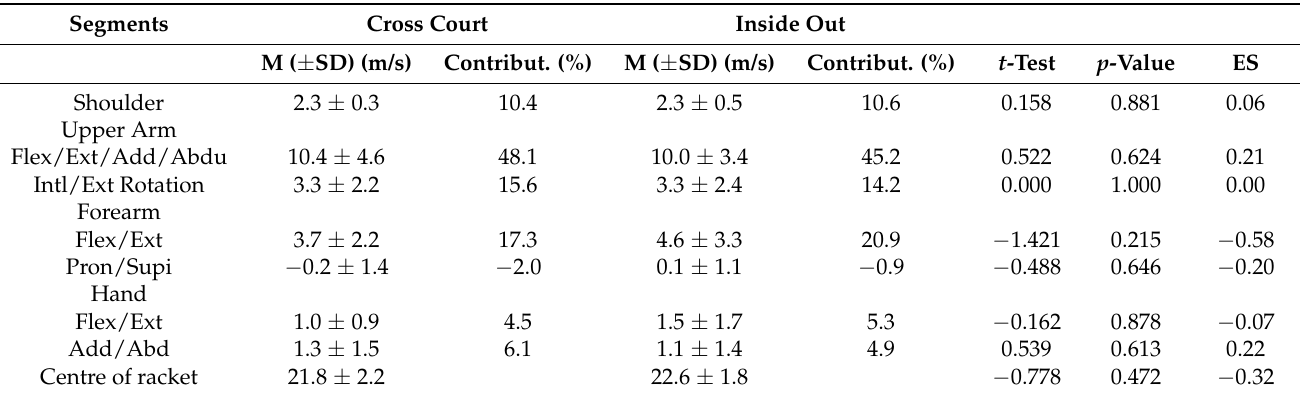
Table 2. Contribution of the upper limb rotations to the racket head velocity in cross-court and inside-out